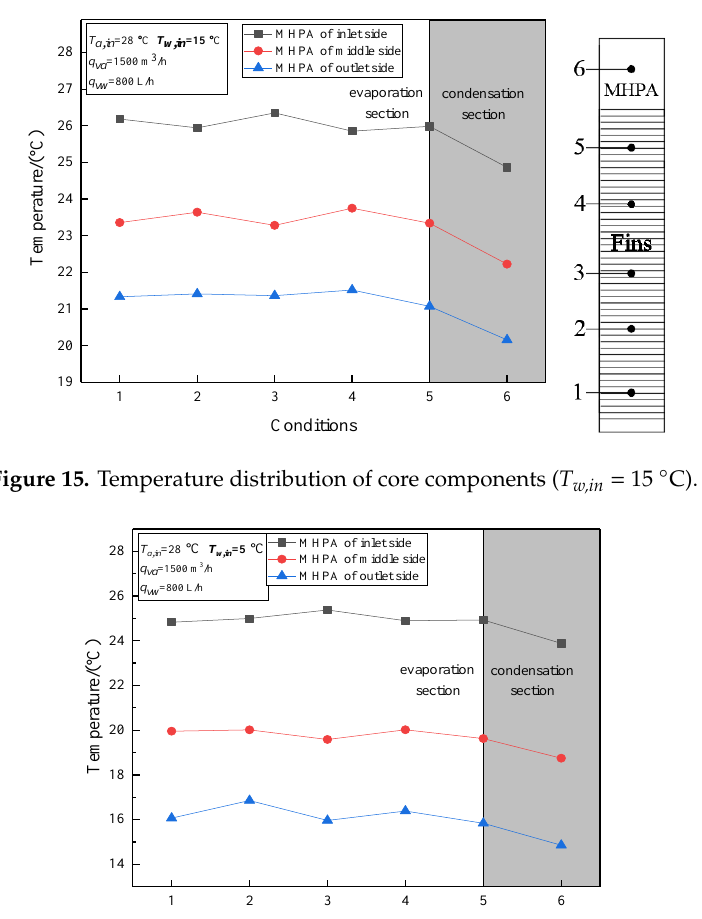
Figure 16. Temperature distribution of the core components ( T w,in = 5 °C).